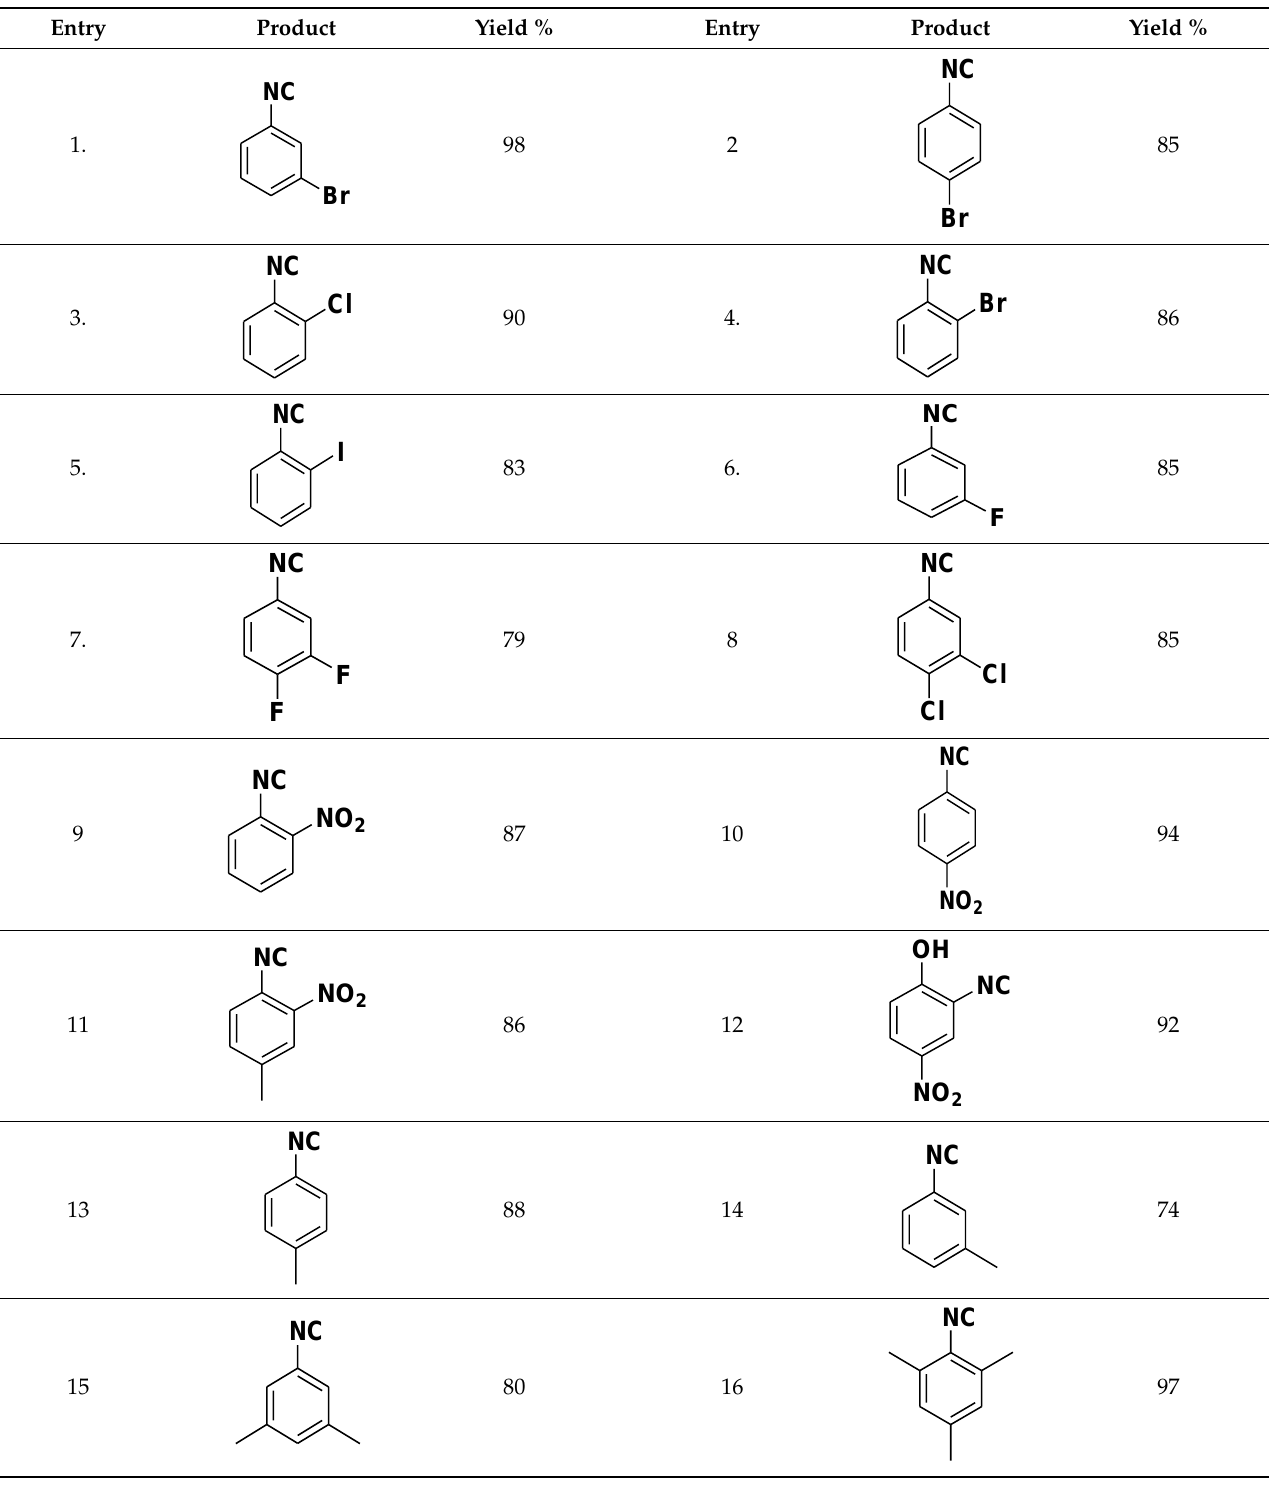
Figure 3. Synthesis of Passerini product using 2-isocyanobenzothiazole generated in situ . Table 4 . Synthesis of isocyanides via formamide dehydration utilizing the optimized reaction conditions with POCl 3 under solvent free conditions (see above).